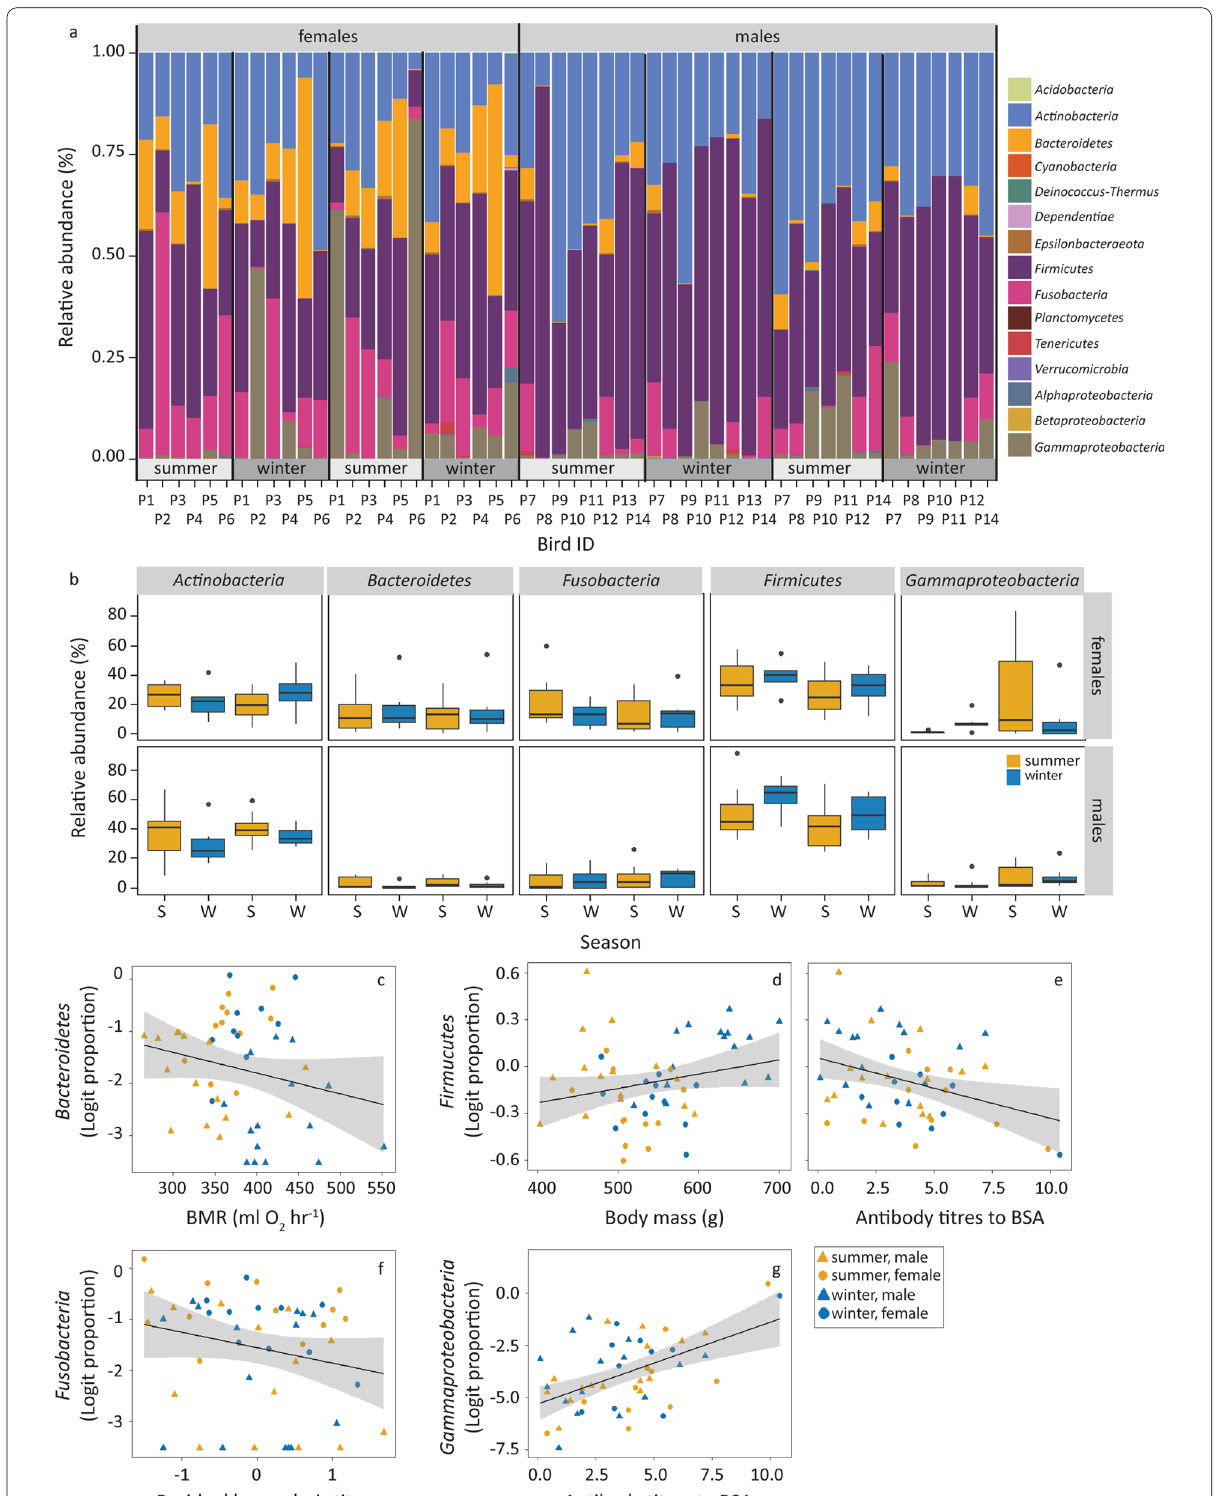
Fig. 5 (See legend on previous